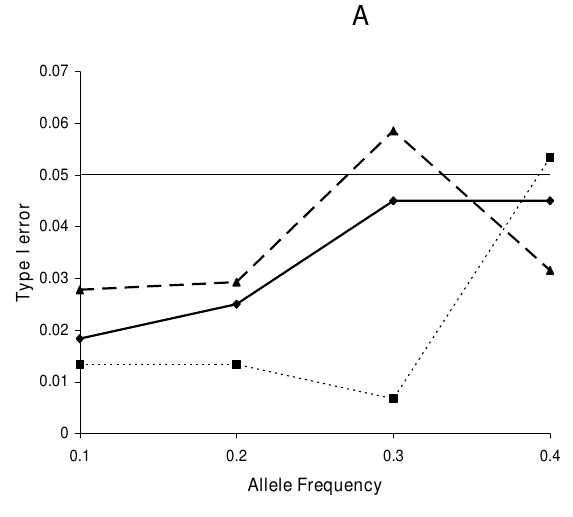
Type I error of logistic model (solid) and log-linear viduals (dashed) as a function of allele frequency.